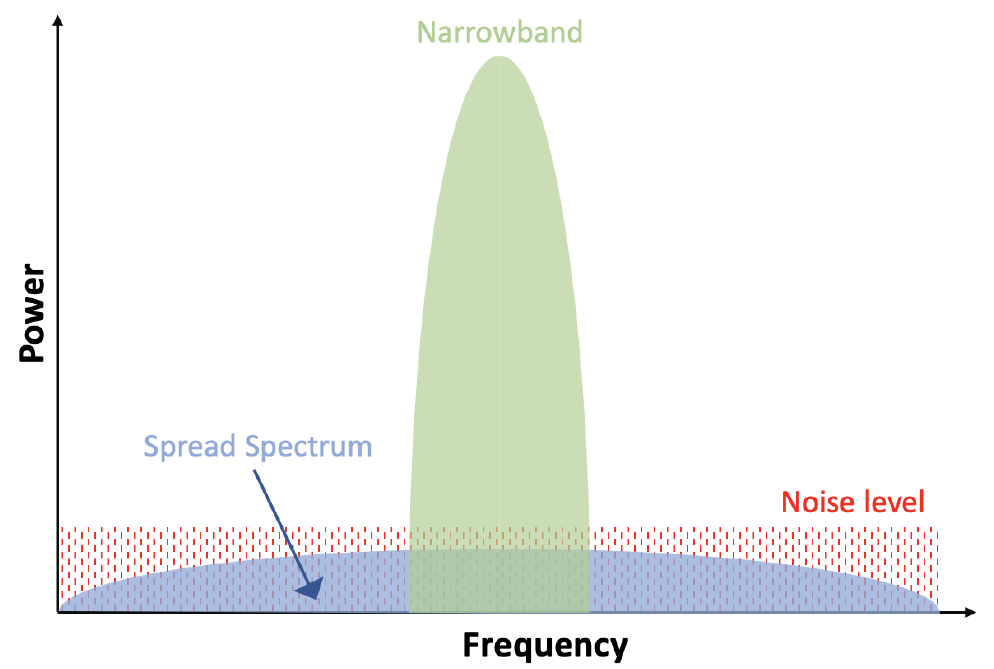
Figure 7. Narrowband vs Spread